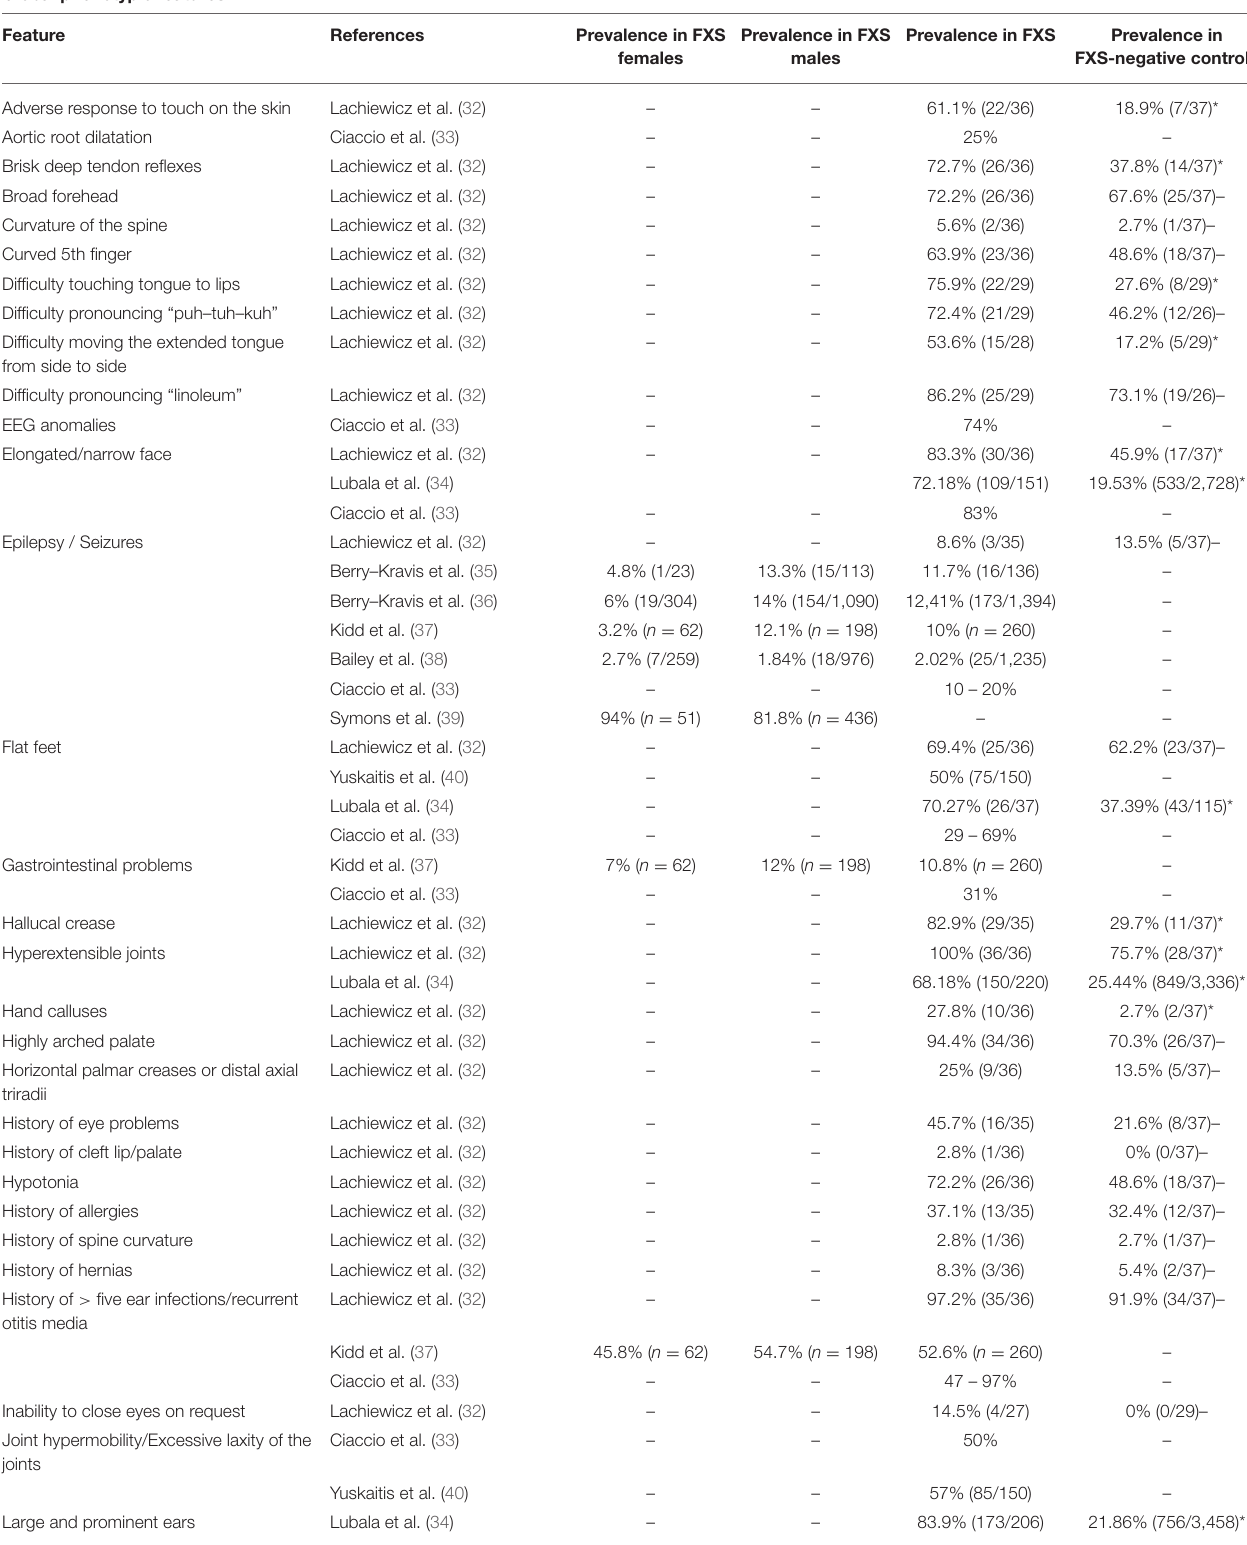
TABLE 1 | Reported prevalence of heterogeneous phenotypic features in FXS patients in several